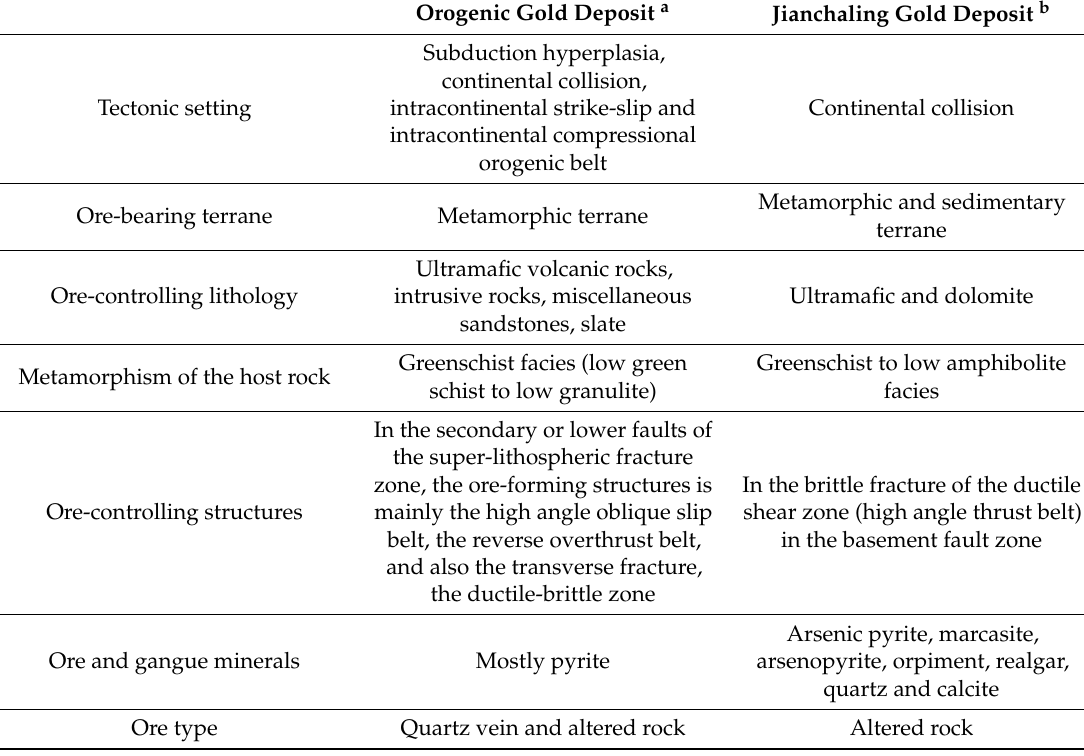
Table 7. Geological characteristics comparison between the Jianchaling and Orogenic gold